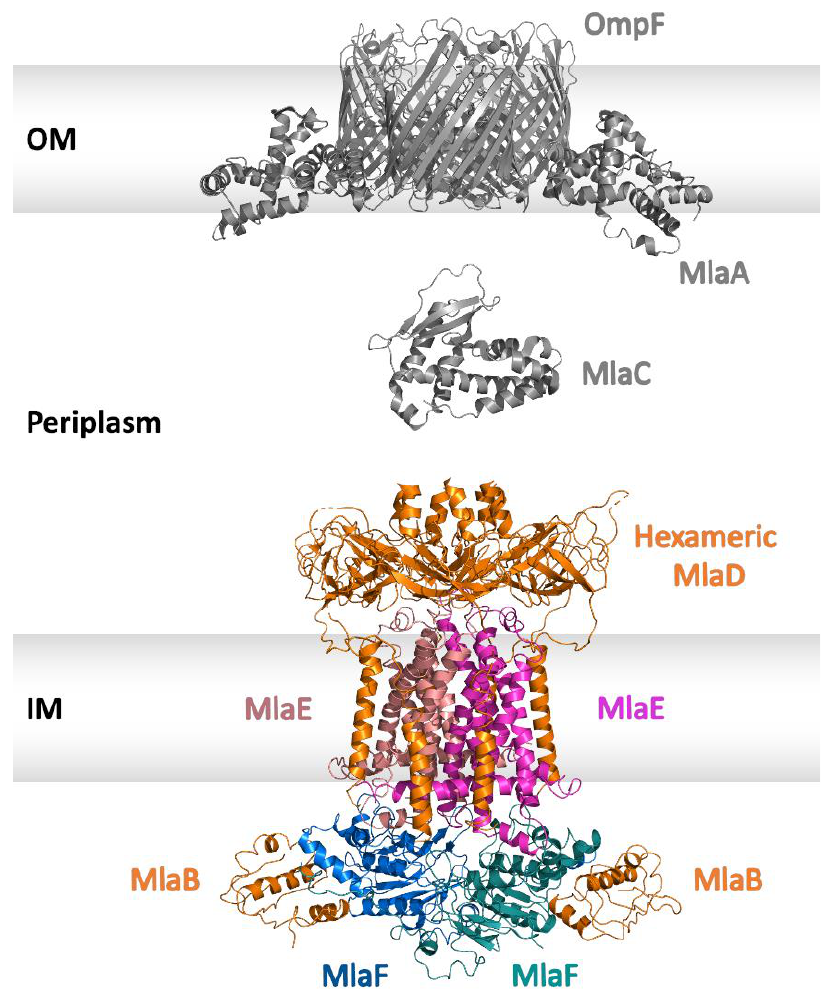
Figure 8. Structural components of the Mla system in a cartoon representation. The homo-trimeric complex of OmpF and MlaA (PDB: 5NUO) situated in the outer membrane is shown in grey color. MlaC (PDB: 6GKI) is shown in the periplasm in grey color. Note: the exact number of MlaC molecules in the periplasm is unknown. The inner membrane complex of MlaFEDB (PDB: 6ZY2) is shown in color: hexameric MlaD, and both MlaB molecules are shown in orange. The two MlaE molecules are shown in salmon and light magenta. The two molecules of MlaF are shown in marine and deep teal. Outer membrane (OM) and inner membrane (IM) are displayed as grey boxes. The peptidoglycan layer is omitted for reasons of clarity.